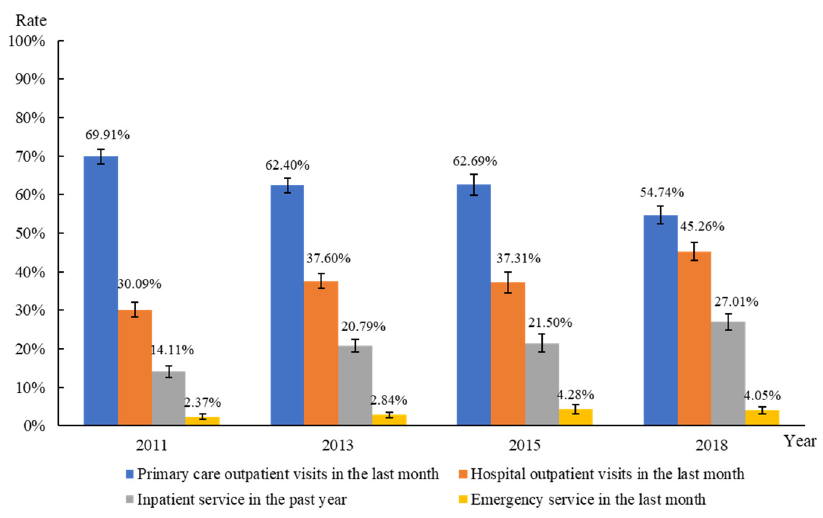
Figure 2. Outpatient services, ER services, and hospital inpatient services utilization from 2011 to 2018.